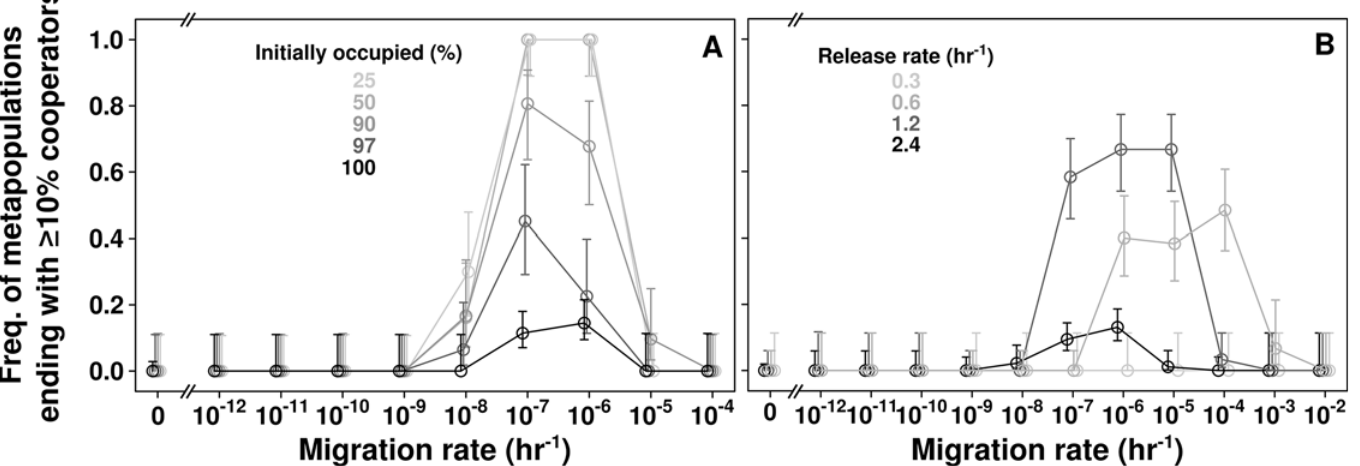
Fig 5. Intermediate migration rates, initially empty locations, and intermediate release rates promote the survival of cooperation. Here, we consider metapopulations of C and D . A ) Varying the fraction of the 144 locations initially occupied by populations of 10 5 cells at a C to D ratio of 1:1. B ) Initially fully- occupied metapopulations as in A , with different cooperator release rates. Error bars were calculated as in Fig 3. In all cases, n (cid:6) 30. Note the break on the X-axis. Points are shifted slightly about the x-axis to aid visualization.